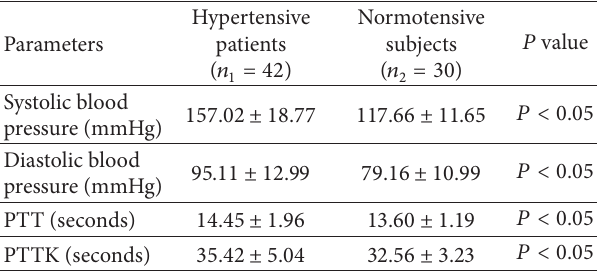
Student’s 𝑡 -test analysis. 𝑃 < 0.05 is significant.